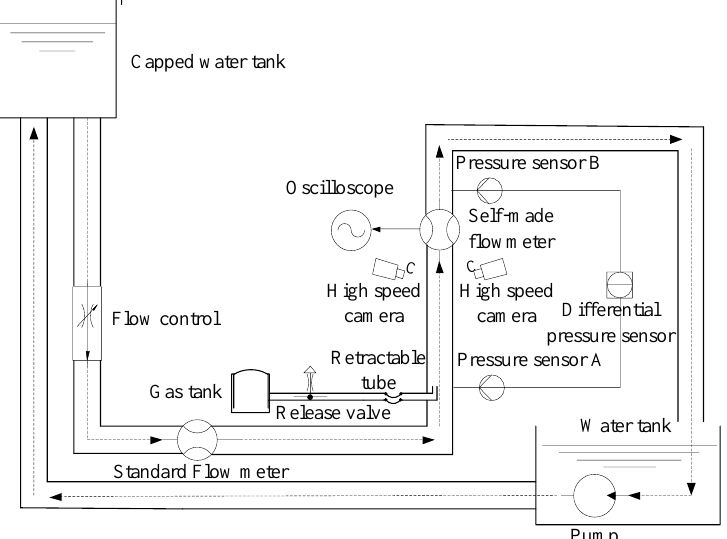
Figure 8. The experimental setup diagram.